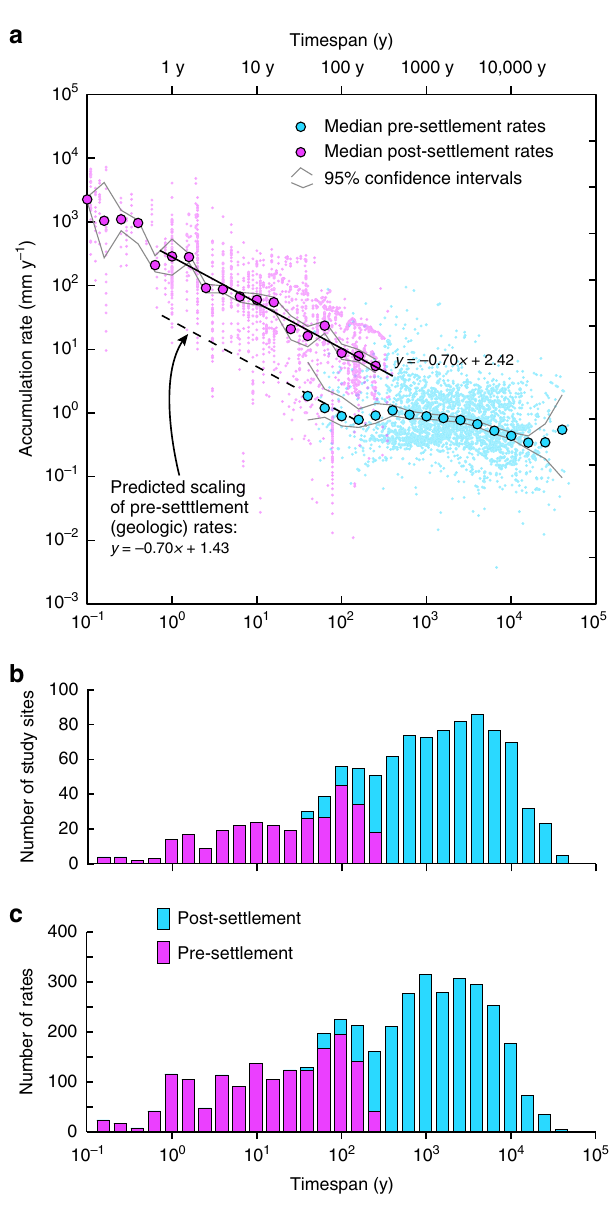
Fig. 4 Alluvium accumulation rates versus timespan from 0.1 y to 40 k.y. a Plot of alluvium accumulation rates versus measurement timespan across timespans from 0.1 y to 40 k.y. Data are divided into pre- and post- settlement (ages >200 y and <200 y, respectively). Raw data are shown as small colored circles. Larger fi lled circles are the median rates for pre- and post-settlement data in 0.2 log timespan bins. Pre- and post-settlement rates co-occur in timespan bins 1.6 – 2.4 log years (i.e. ~40 – 400 y). Note how at these timespans median post-settlement rates are consistently ~10× faster than median pre-settlement rates. Medians are based on Monte Carlo modeling of the raw data that takes into account timespan measurement errors. Gray lines show the 95% con fi dence intervals associated with this error modeling. See Methods and main text for details. Regression line and equation through the post-settlement data highlights the clear timespan dependent scaling of post-settlement rates between timespans of 1 and 400 y. The dashed regression line through the pre- settlement data and accompanying equation shows the predicted scaling of pre-settlement (i.e., natural geologic) rates at timespans from 1 to ~40 y. This predicted scaling is used to estimate the difference between post- settlement rates and the expected pre-settlement (i.e., natural geologic) rate of accumulation at timespans between 1 and 40 y. b Histogram showing number of study sites within each 0.2 log timespan bin. c Histogram showing counts of pre- and post-settlement rates within each timespan